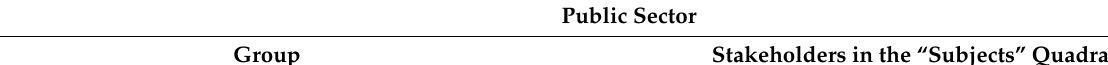
Table 4. Stakeholders overview in the “subject”